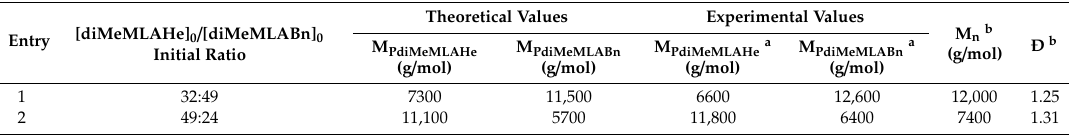
Table 2. Characteristics of the two amphiphilic block copolymers prepared by sequential aROP of diMeMLAHe and diMeMLABn using 1-pyreneacetic acid / P 4 - t -Bu